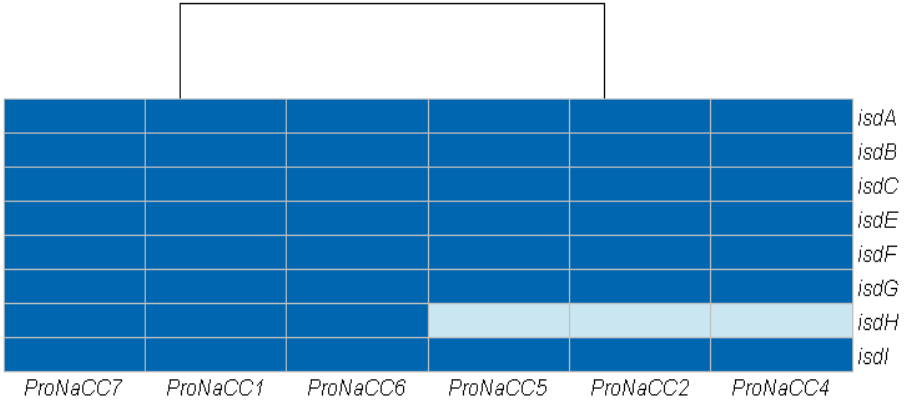
Figure 5. Heat map showing the genes coding for factors involved in the uptake of iron and metabolism among the six enterotoxigenic S. aureus strains (dark blue: sequence detected; light blue: sequence not detected).